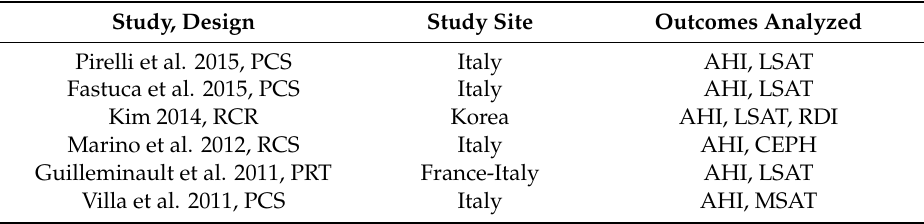
Figure 1. Study search flowchart. Table 3. General Characteristics of Included